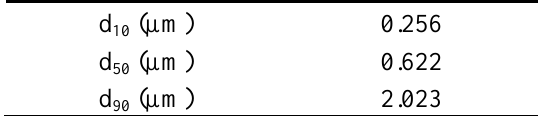
Table 1. Particle size distributions for the carbon black